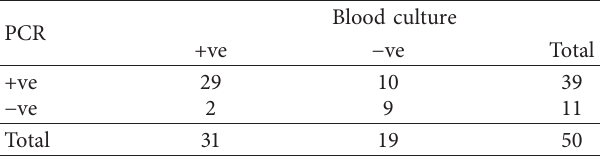
Table 4: Comparison of blood culture results with proved sepsis. Blood culture